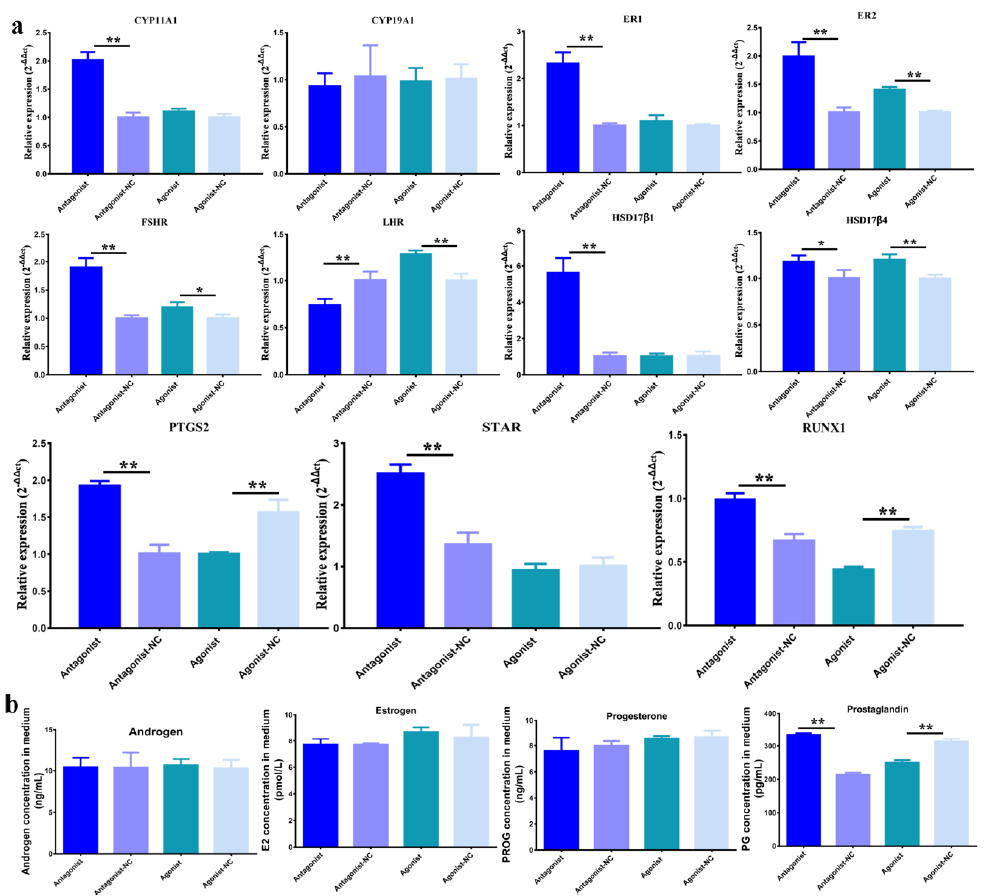
Figure 3. The impact of H3K27me3 on steroidogenesis in pGCs. (a) The expression patterns of steroidogenesis related genes when treated with agonist GSK-126 or agonist GSK-J4 in pGCs. Antagonist-NC and agonist-NC were the controls of antagonist GSK-126, and agonist GSK-J4, respectively. The * indicates p < 0.05 and ** indicates p < 0.01. (b) The synthesis of hormones androgen, estrogen, prostaglandin, and progesterone with antagonist GSK-126, antagonist-NC, agonist GSK-J4, and agonist-NC in pGCs. Genes 2020 , 11 , x FOR PEER REVIEW